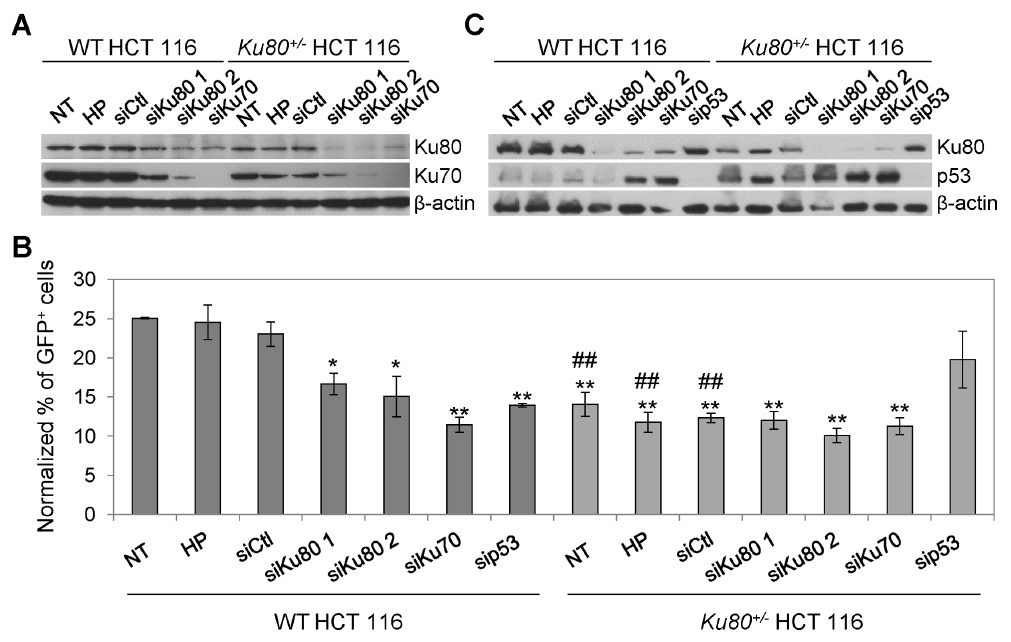
Figure 3. HIV-1-driven GFP expression in WT HCT 116 cells is decreased by transient depletion of Ku. ( A – C ) Wild-type (WT) and Ku80 + / 2 human colon carcinoma HCT 116 cells were transfected with an unrelated sequence (siCtl) or with siRNAs directed against Ku80 (siKu80 1 or 2), Ku70 (siKu70) or p53 (sip53). Seventy-two hours later, the protein levels of Ku80 and Ku70 ( A ) or Ku80 and p53 ( C ) were assessed by Western-blot analysis. Actin levels were monitored to ensure equal loading of lanes. Alternatively, 72 h upon transfection, the cells were transduced with XCD3 (HIV-1 env - nef - IRES- gfp ) at low m.o.i. ( , 0.3) for additional 48 h followed by cytofluorimetric assessment of green fluorescent protein (GFP) expression ( B ). NT (non-transfected) and HP (Hiperfect H ) correspond to cells kept in control condition or exposed to the same amount of liposomes as used for transfection but in the absence of siRNA, respectively. In ( B ), the percentages of GFP-positive (GFP + ) cells were normalized to the total viral DNA content per cell as determined by quantitative PCR (Q-PCR) 24 h after transduction. The results obtained from at least 3 independent experiments were then normalized to a GFP expression level of 25% (of note, the level of GFP expression of NT, HP or siCtl WT cells before normalization was always comprised between 20 and 30%). The results are expressed as mean 6 SEM. *, p , 0.05 and **, p , 0.01 as compared to HP and siCtl- transfected WT cells; # , p , 0.05 and ## , p , 0.01 as compared to WT cells subjected to the same transfection condition.